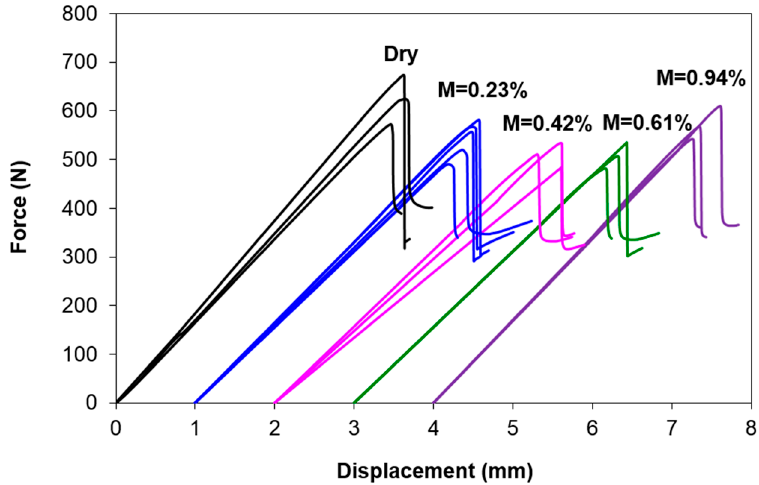
Figure 5. Force–displacement curves of ENF specimens at various moisture content levels.